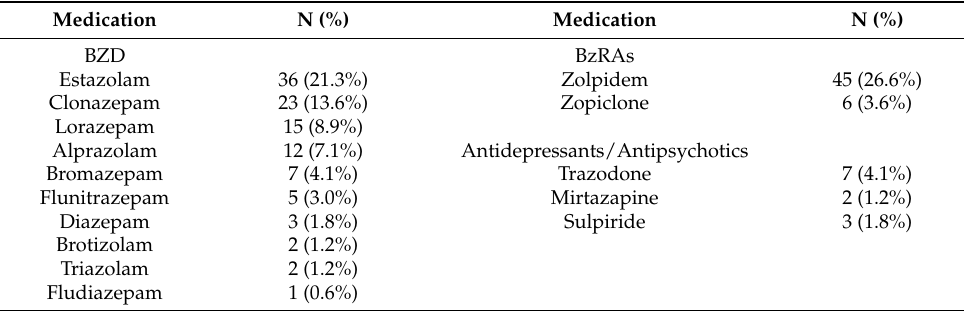
Table 1. The number and percentage of participants using different hypnotic